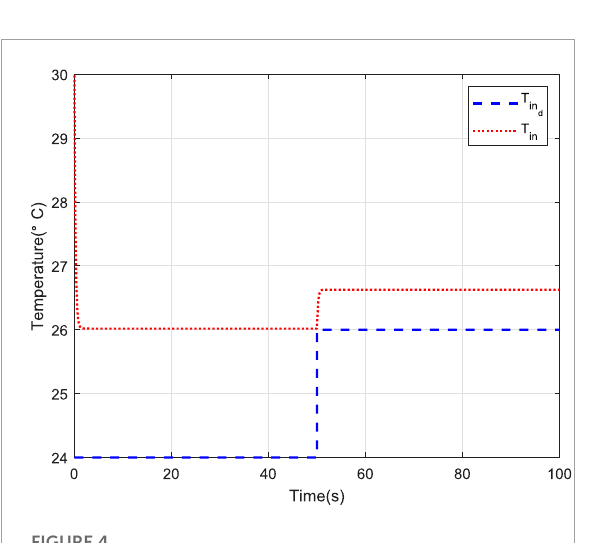
FIGURE 4 Tracking performance without NN compensation.